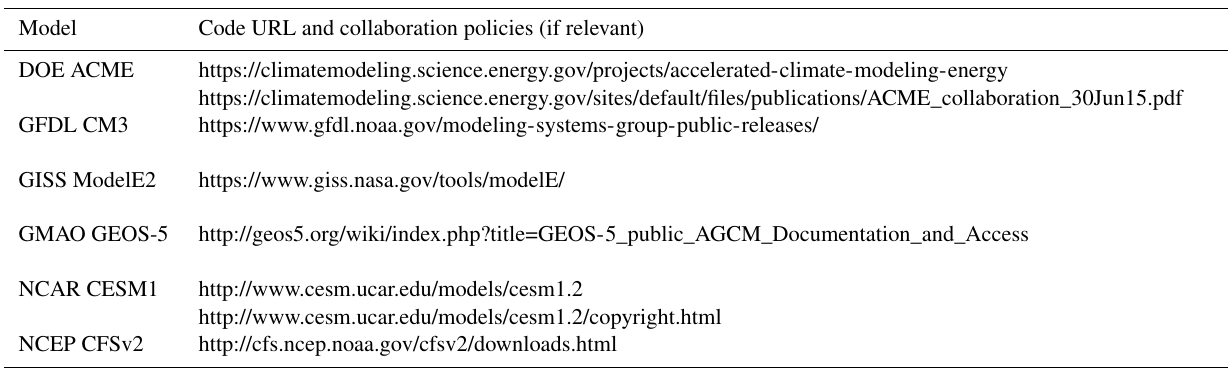
Table 3. Code availability at each center. Model Code URL and collaboration policies (if